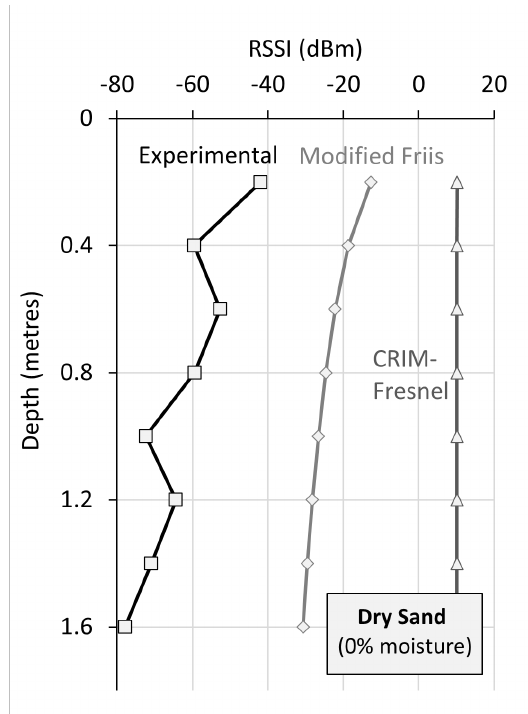
Figure 4. LoRa signal strength in dry sand at depths 0.2 to 1.6